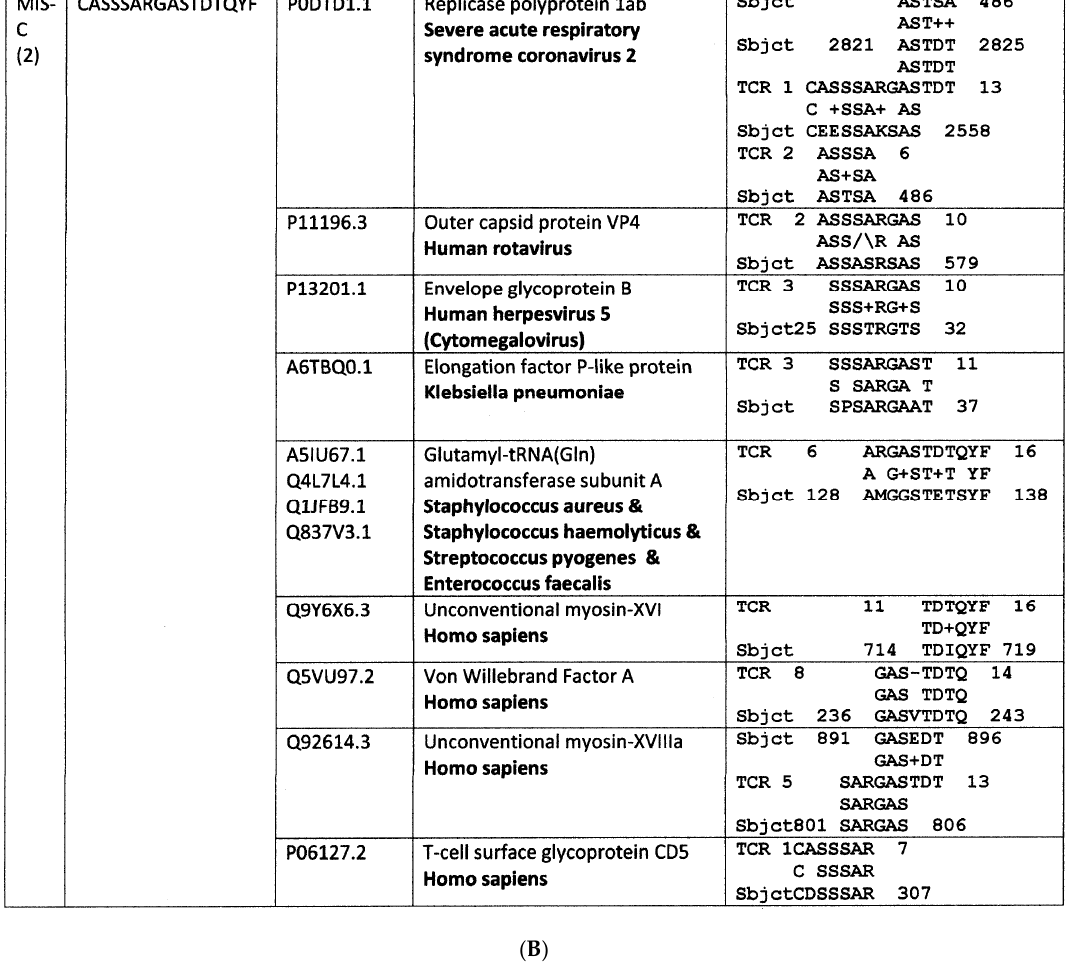
Figure 7. ( A , B ) Selected TCR sequences from a MIS-C patient [79] and their similarities to viral, bacterial and human proteins found by BLAST. Not only does each TCR sequence mimic a virus, bacterium and/or human protein, the figure also illustrates that many of these viral, bacterial and human proteins mimic each other. Additionally, the specific human proteins identified by this analysis correspond with well-known targets of autoimmune processes associated with MIS-C, including cardiomyopathies (myosins) and coagulopathies (von Willebrand Factor, fibrinogen and plasmin). Numbers in the second column from the left are the UNIPROT identifiers.